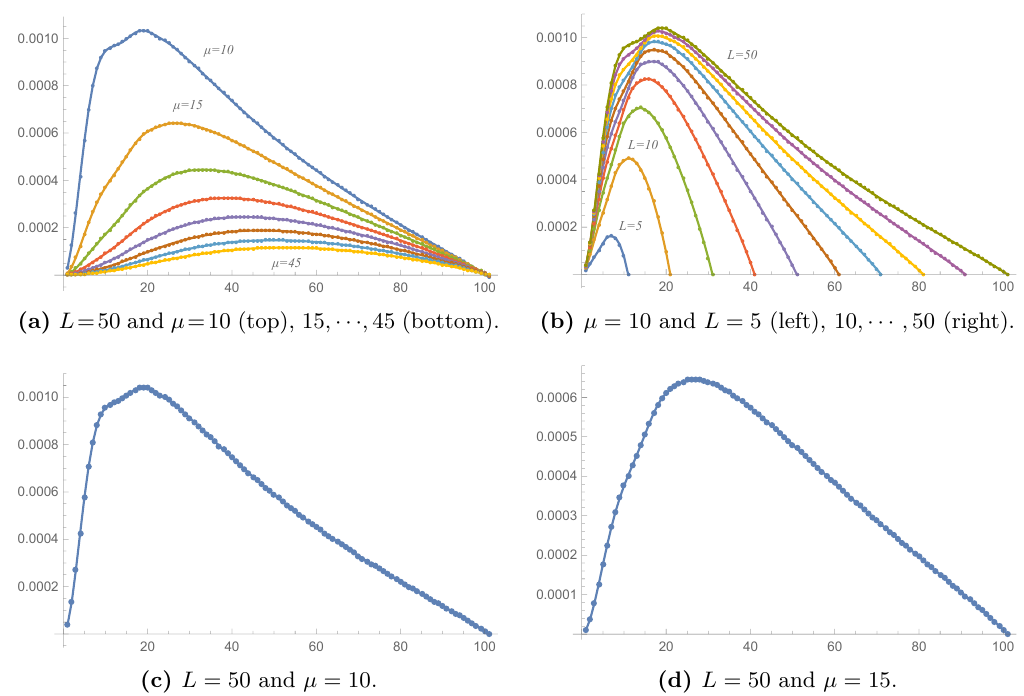
Figure 2 . The EE of the fuzzy sphere, S EE ( x ) (up to − λ 2 ln λ 2 / 16 R 2 factor). The horizontal axis is x . R is set to be